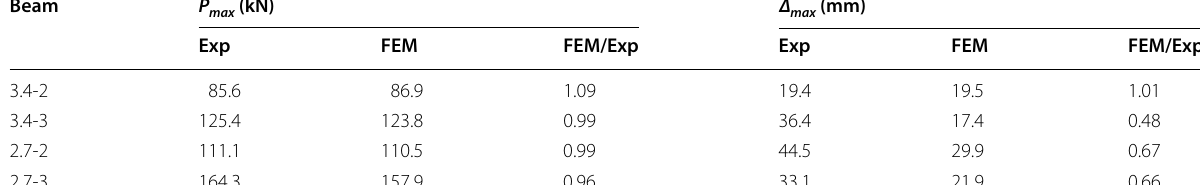
Table 2 Comparison between experiment and finite element analysis. Beam